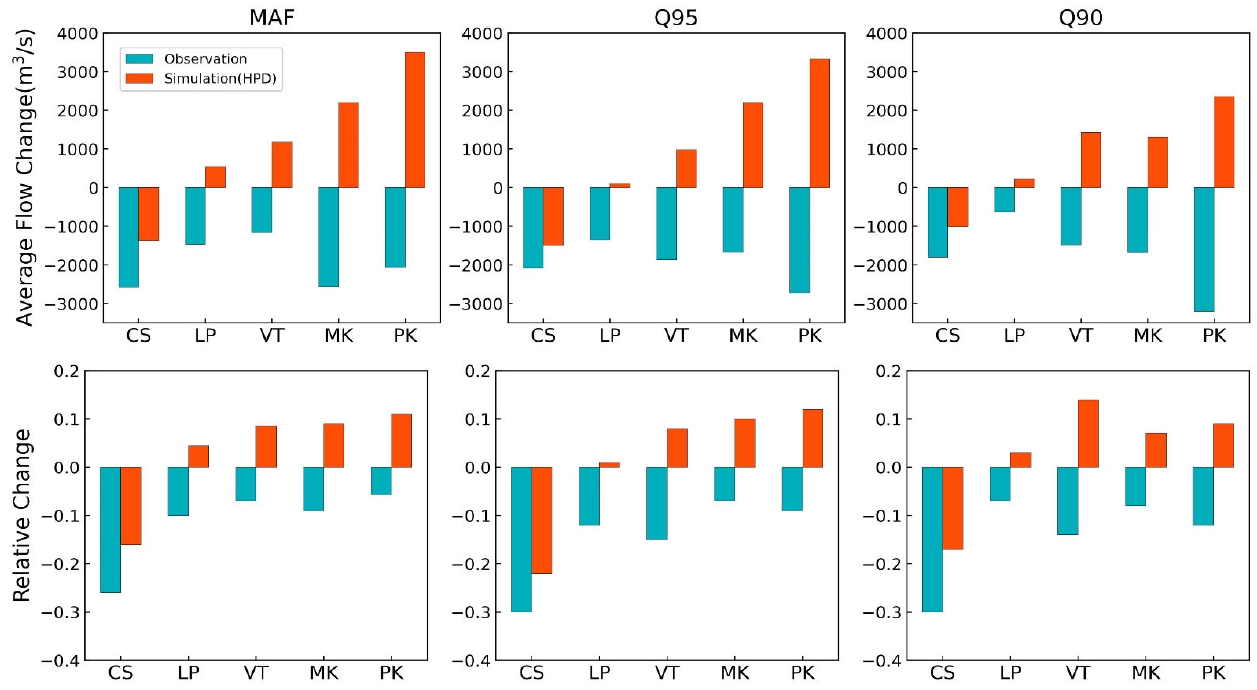
Figure 8. Average and relative change of the observed and simulated flood obtained by HPD model at five selected stations in human impact period (2008–2015) compared with testing period (1998–2007).